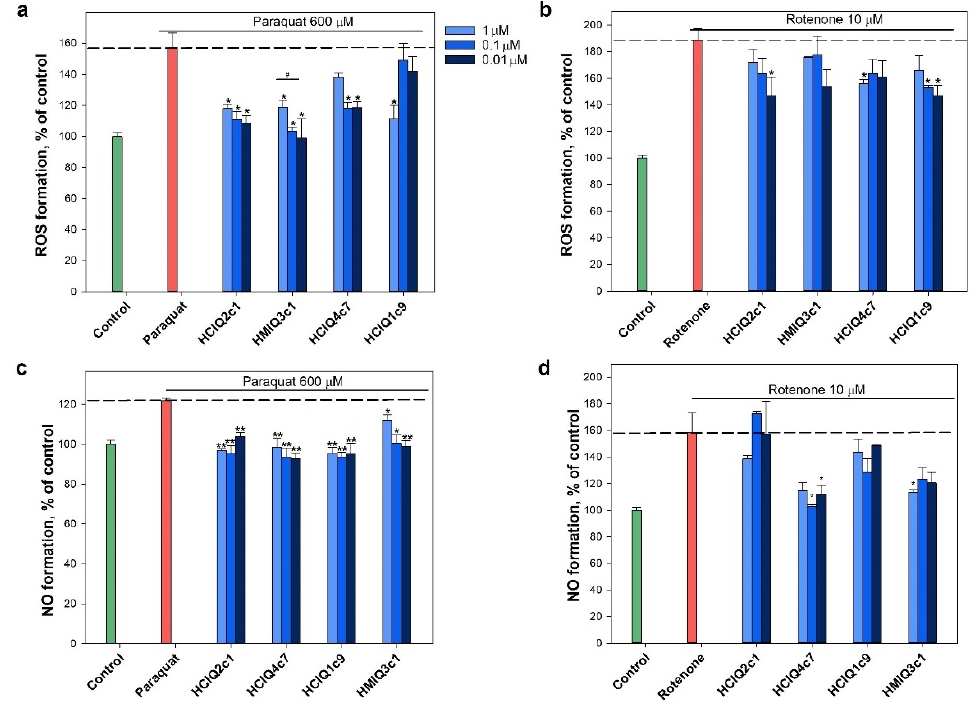
Figure 8. Effects of the peptides on intracellular ROS and NO formation. The effects of the peptides on ROS formation into Neuro-2a cells treated by 600 µM paraquat ( a ) and 10 µM rotenone ( b ). The effects of peptides on NO formation into the cells treated by 600 µM paraquat ( c ) and 10 µM rotenone ( d ). Cells were incubated with peptides for 1 h at 37 °C, then 3 or 1 h with paraquat or rotenone, respectively. The data are shown as the means ± SE; *— p < 0.05, **— p < 0.01, #— p < 0.05 when comparing concentrations of the same peptide.